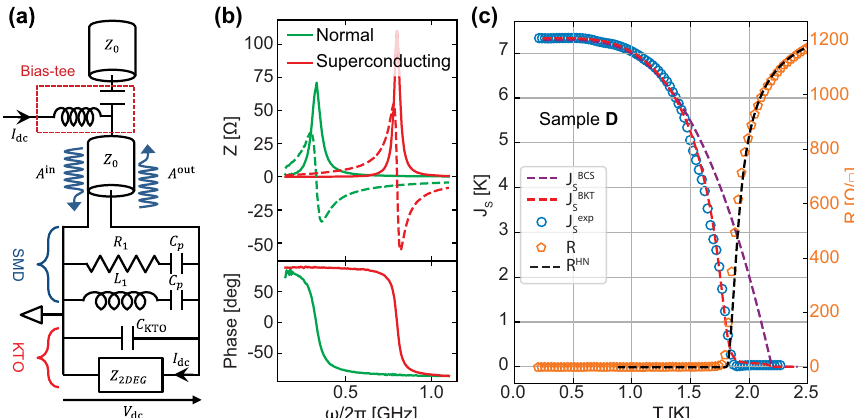
Fig. 4 | Microwave measurement of the KTaO 3 2-DEG. a Schematics of the measurement setup adapted from ref. 26. The contribution of the sample is represented by the 2-DEG impedance, Z 2 DEG , and the parallel capacitive contribu- tion of the KTaO 3 substrate, C KTO . SMD components, resistor R 1 =75 Ω , inductor L 1 =6.5nH, are placed in parallel to de fi ne a resonating circuit. Large SMD capa- citors C p =2 μ F block the dc signals in L 1 and R 1 without in fl uencing the signals at microwavefrequencies.There fl ectioncoef fi cientatthecircuitsample Γ ( ω )= A out extracted from the measurement as described in ref. 26. A bias-tee is used to separate the dc current and the microwave one. b Top: Real (full lines) and ima- ginary (dashed lines) parts of the 2-DEG impedance as a function of frequency in the normal state at T=2.5K and in the superconducting state at T=0.2K after a